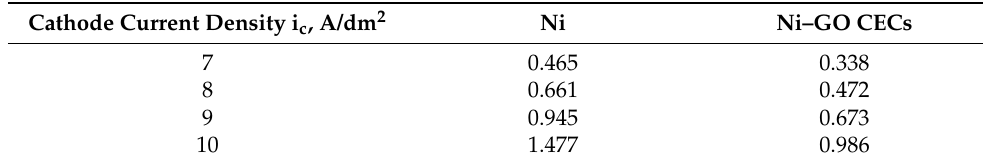
Table 2. Surface roughness parameter Ra values in μ m of nickel coatings.